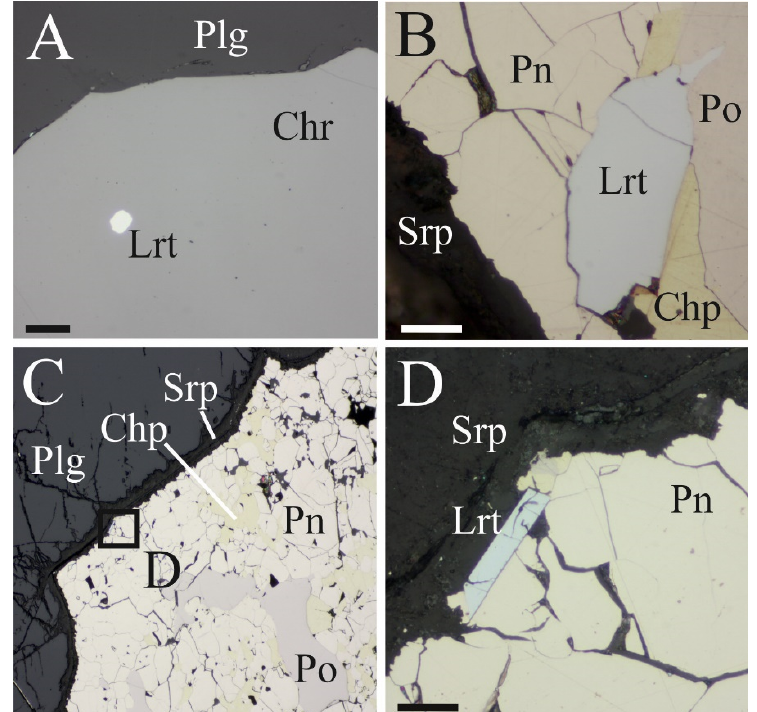
Figure 3. Digital image in reflected plane polarized light showing laurite from the Merensky Reef. ( A ) Laurite enclosed in fresh chromite. ( B and C ) Zoned laurite and ( D ) enlargement of ( C ). Abbreviations: Lrt = laurite, Plg = plagioclase, Chr = chromite, Srp = serpentine, Pn = pentlandite, Po = pyrrhotite, Chp = chalcopyrite. Scale bar = 20 µm.